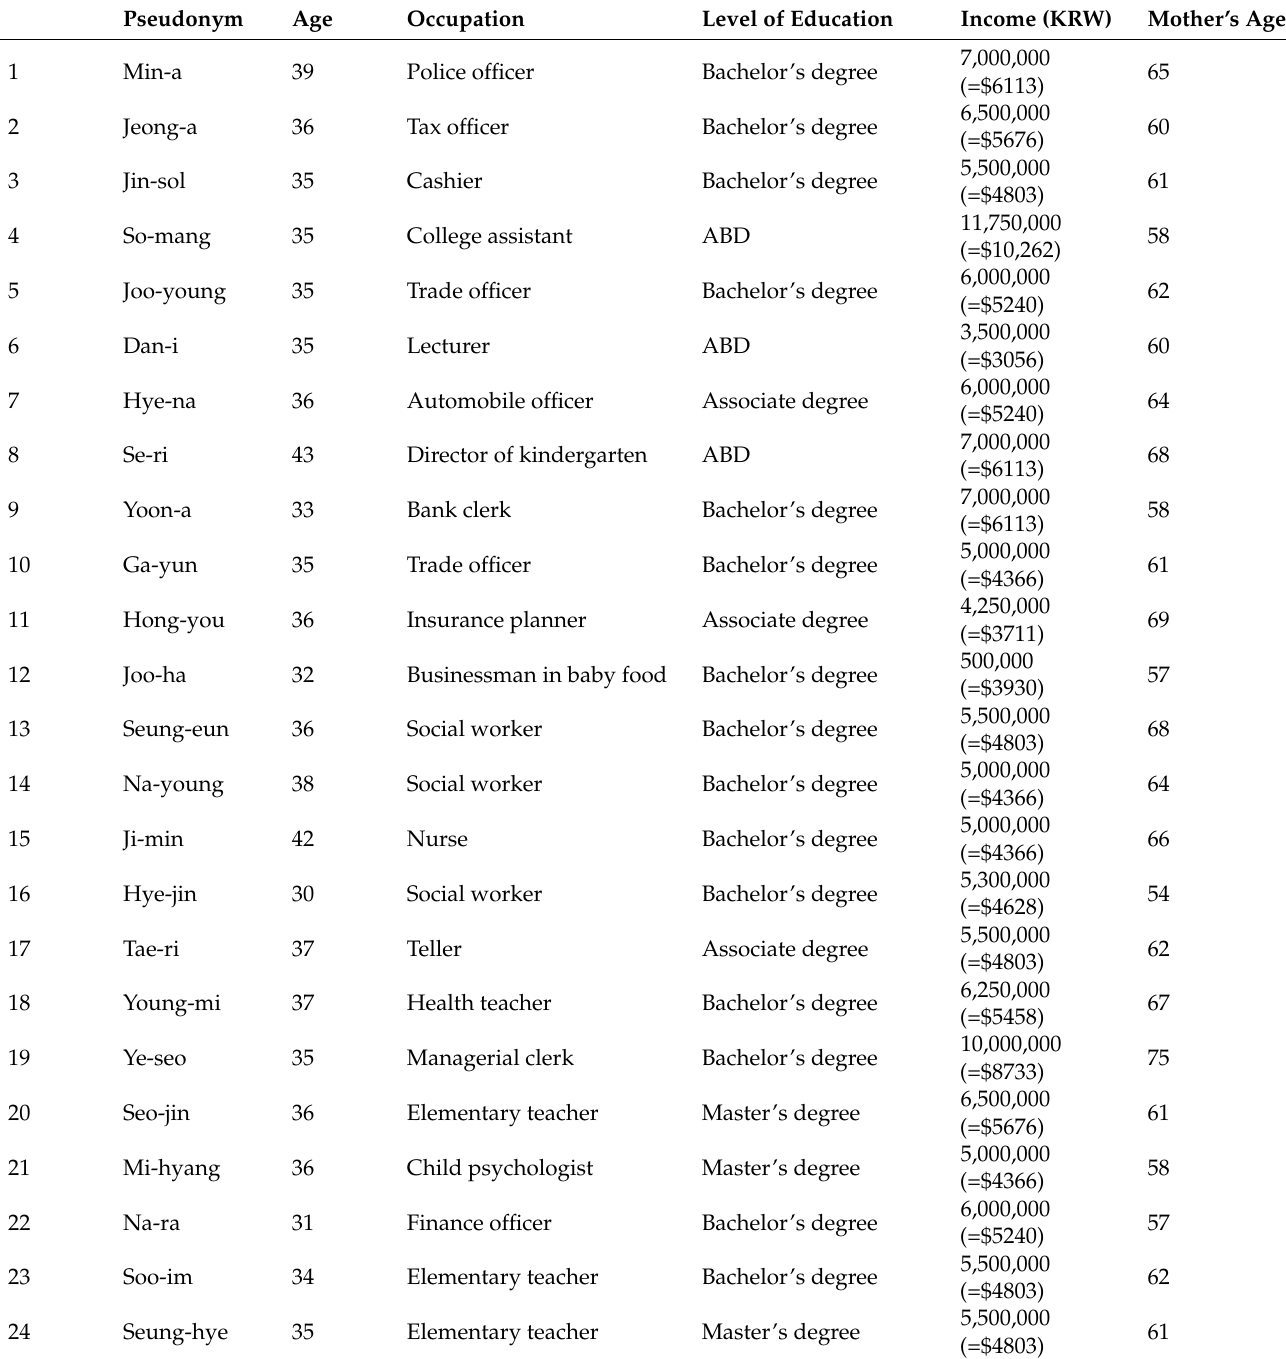
Table 1. Sample Socio-Demographic